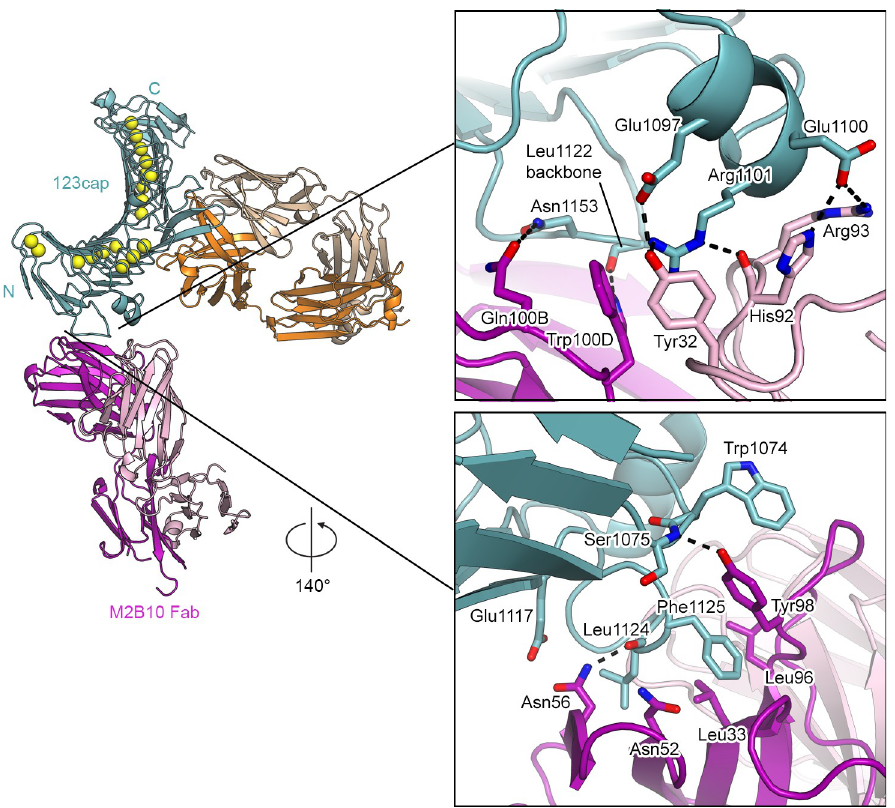
Fig 4. Interactions formed by M2B10 with linker 1 of the RTX domain. Structures are shown as ribbon representation with select residues shown as sticks, with nitrogens colored blue, oxygens colored red, and sulfur colored yellow. Calcium is represented as yellow